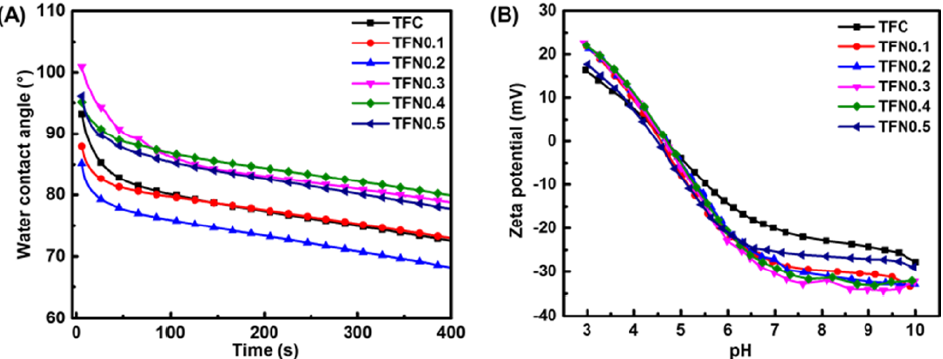
Figure 5. The dynamic water contact angle ( A ) and zeta potential ( B ) characteristics of the membranes with different PTS